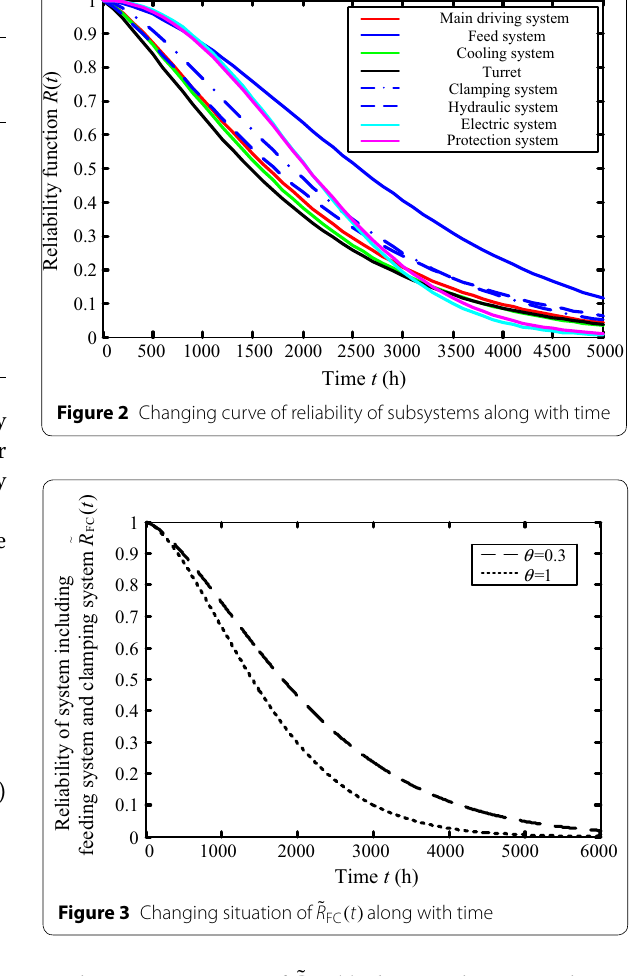
Table 1 Reliability functions and linear correlation